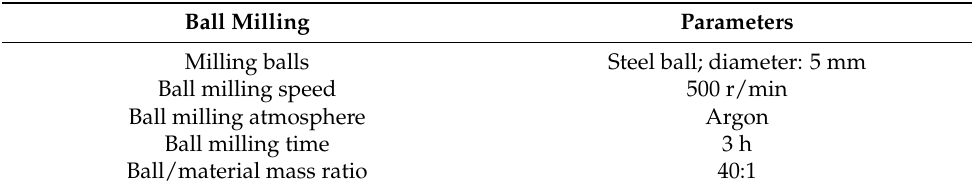
Table 1. Ball milling parameters.